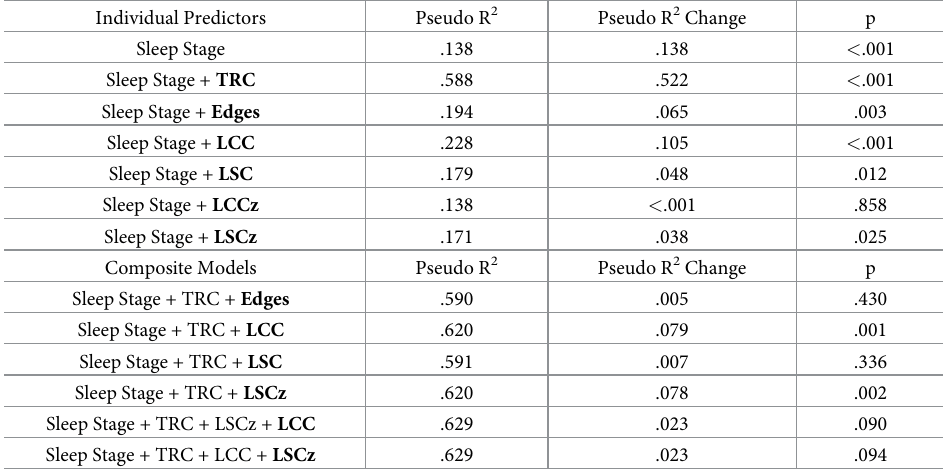
Table 4. Results from cumulative link models in predicting PIRS ratings.